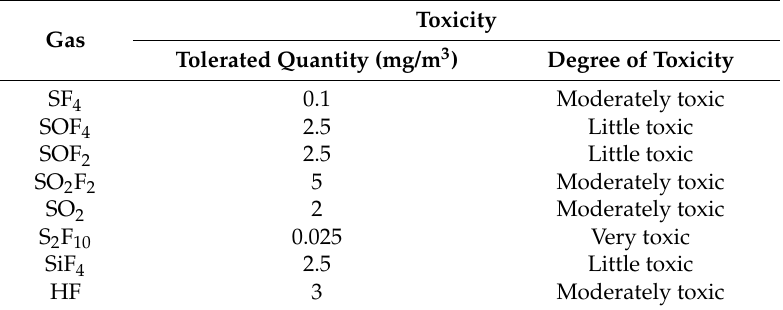
Table 2. Toxicity of some byproducts resulting from the decomposition of SF 6